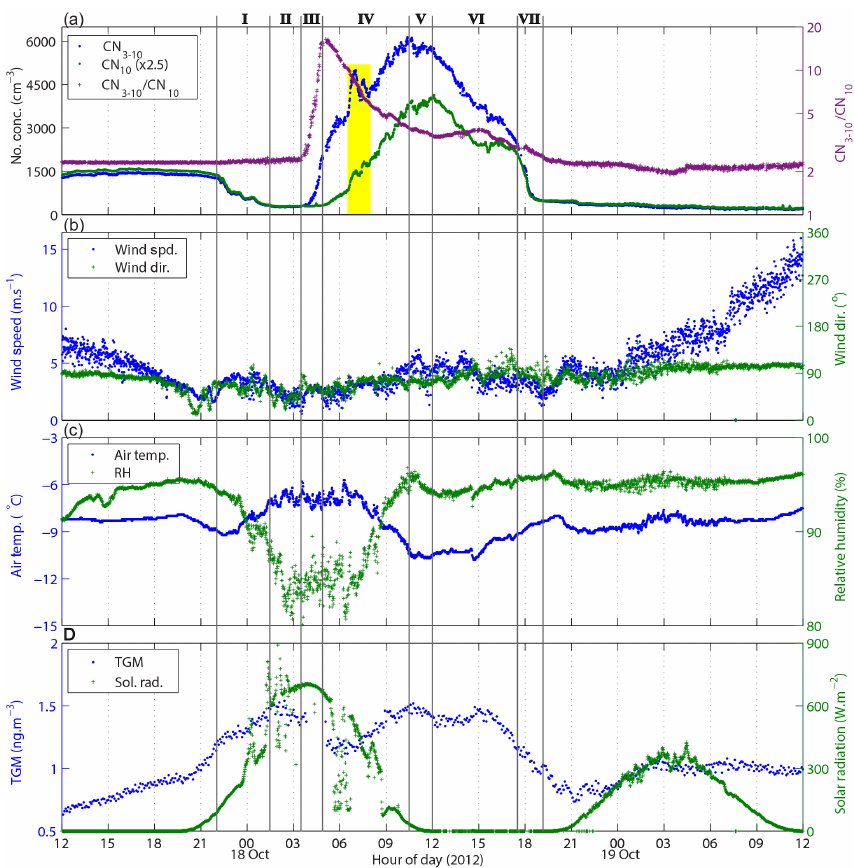
Figure 3. Detailed view of particle formation event along with selected meteorological parameters and TGM concentrations. See text for de- tails of numbered events. (a) Number concentrations of CN 3 − 10 , CN 10 , and (CN 3 –CN 10 ) / CN 10 show the structure of the formation event clearly. Note the delay between increases in the two size bins, and the linearity of the increase in ratio during period III. The highlighted period shows short-term spikes in both aerosol size bins, with no signal in the ratio data, suggesting this is a result of variations in back- ground concentrations. (b) In situ wind direction during the period is constantly from the east, with minimal variation. Wind speed was low throughout the formation event, remaining below 7ms − 1 . This is in contrast to the days before and after the event where high wind speeds were observed. (c) The beginning of the event saw slight increases in temperature simultaneous with a 10% decrease in relative humidity. (d) Solar radiation was found to reach higher levels than any other during the voyage, and decreases in TGM were found to correspond with the period of highest solar radiation. Table 1. Range of model input parameters to test sulfur